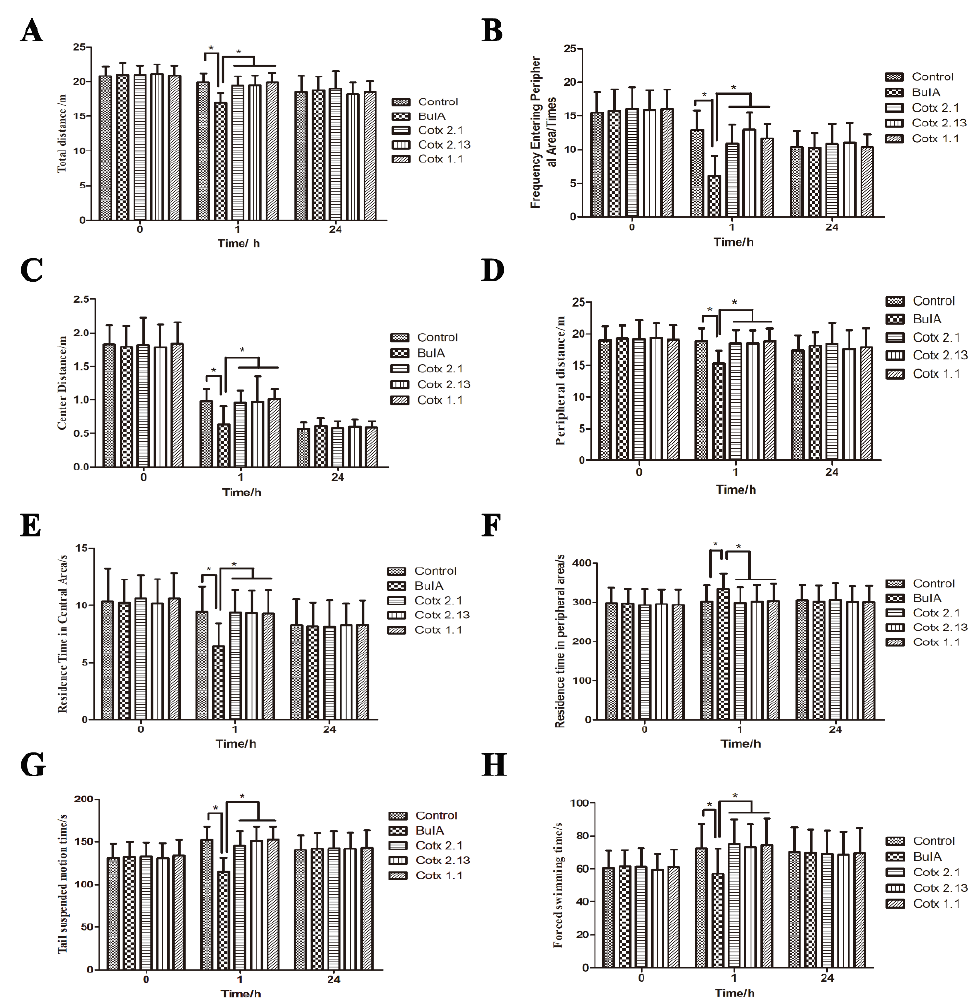
Figure 4. Adverse reactions of BuIA and analogues. Bar graphs represent the mean value ± SEM, * p < 0.05. ( A ) Open field test—total distances: the total distances of the analogue groups and control group had no significant differences ( p > 0.05), but the BuIA group was significantly lower than the other groups ( p < 0.05); ( B ) open field test—frequency entering peripheral area: the frequency entering the peripheral area of the analogue groups and control group showed no significant differences ( p > 0.05), but the BuIA group was significantly lower than the other groups ( p < 0.05); ( C ) open field test—center distance: the center distance of the analogue groups and control group had no significant